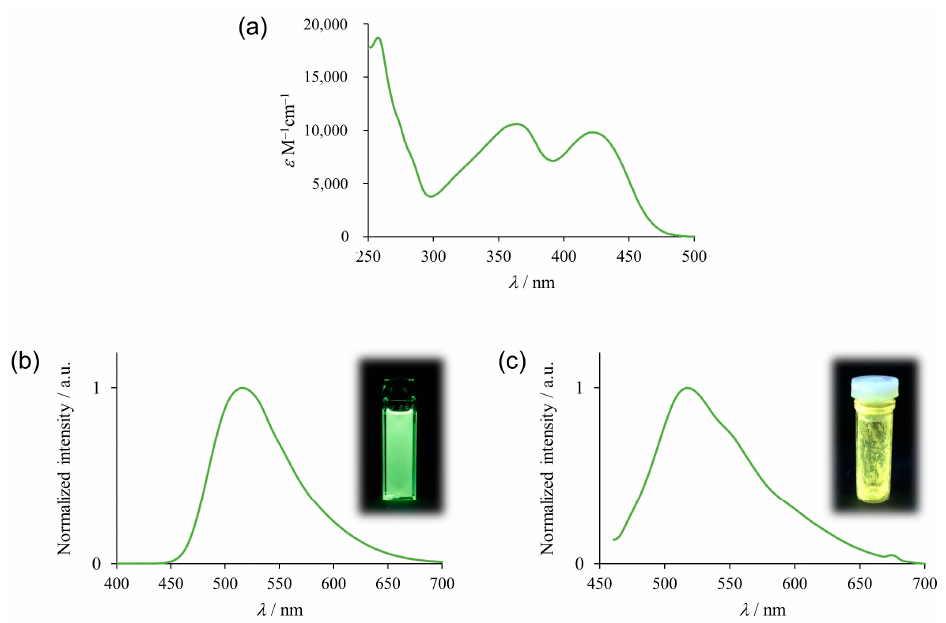
Figure 3. ( a ) Optical absorption spectrum of 3 in CH 2 Cl 2 , ( b ) fluorescence spectrum of 3 in CH 2 Cl 2 , and ( c ) fluorescence spectrum of 3 in the solid state, with photographs under irradiation with light ( λ = 364 nm). Table 2. Photophysical data for 3 a .